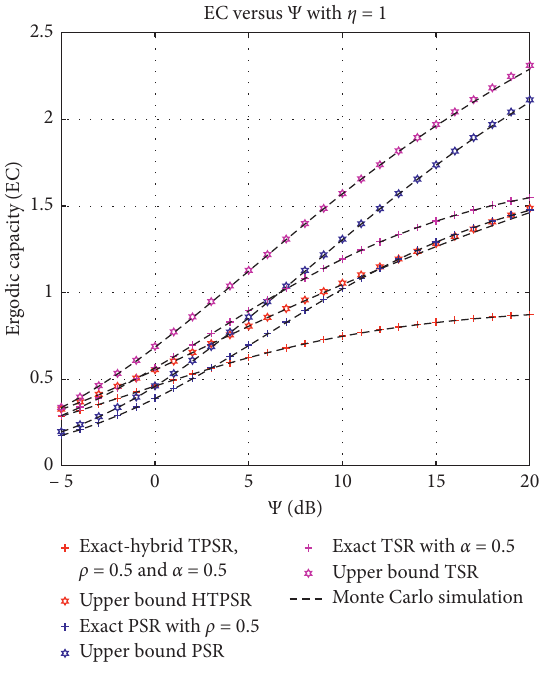
Figure 3: Ergodic capacity versus Ψ